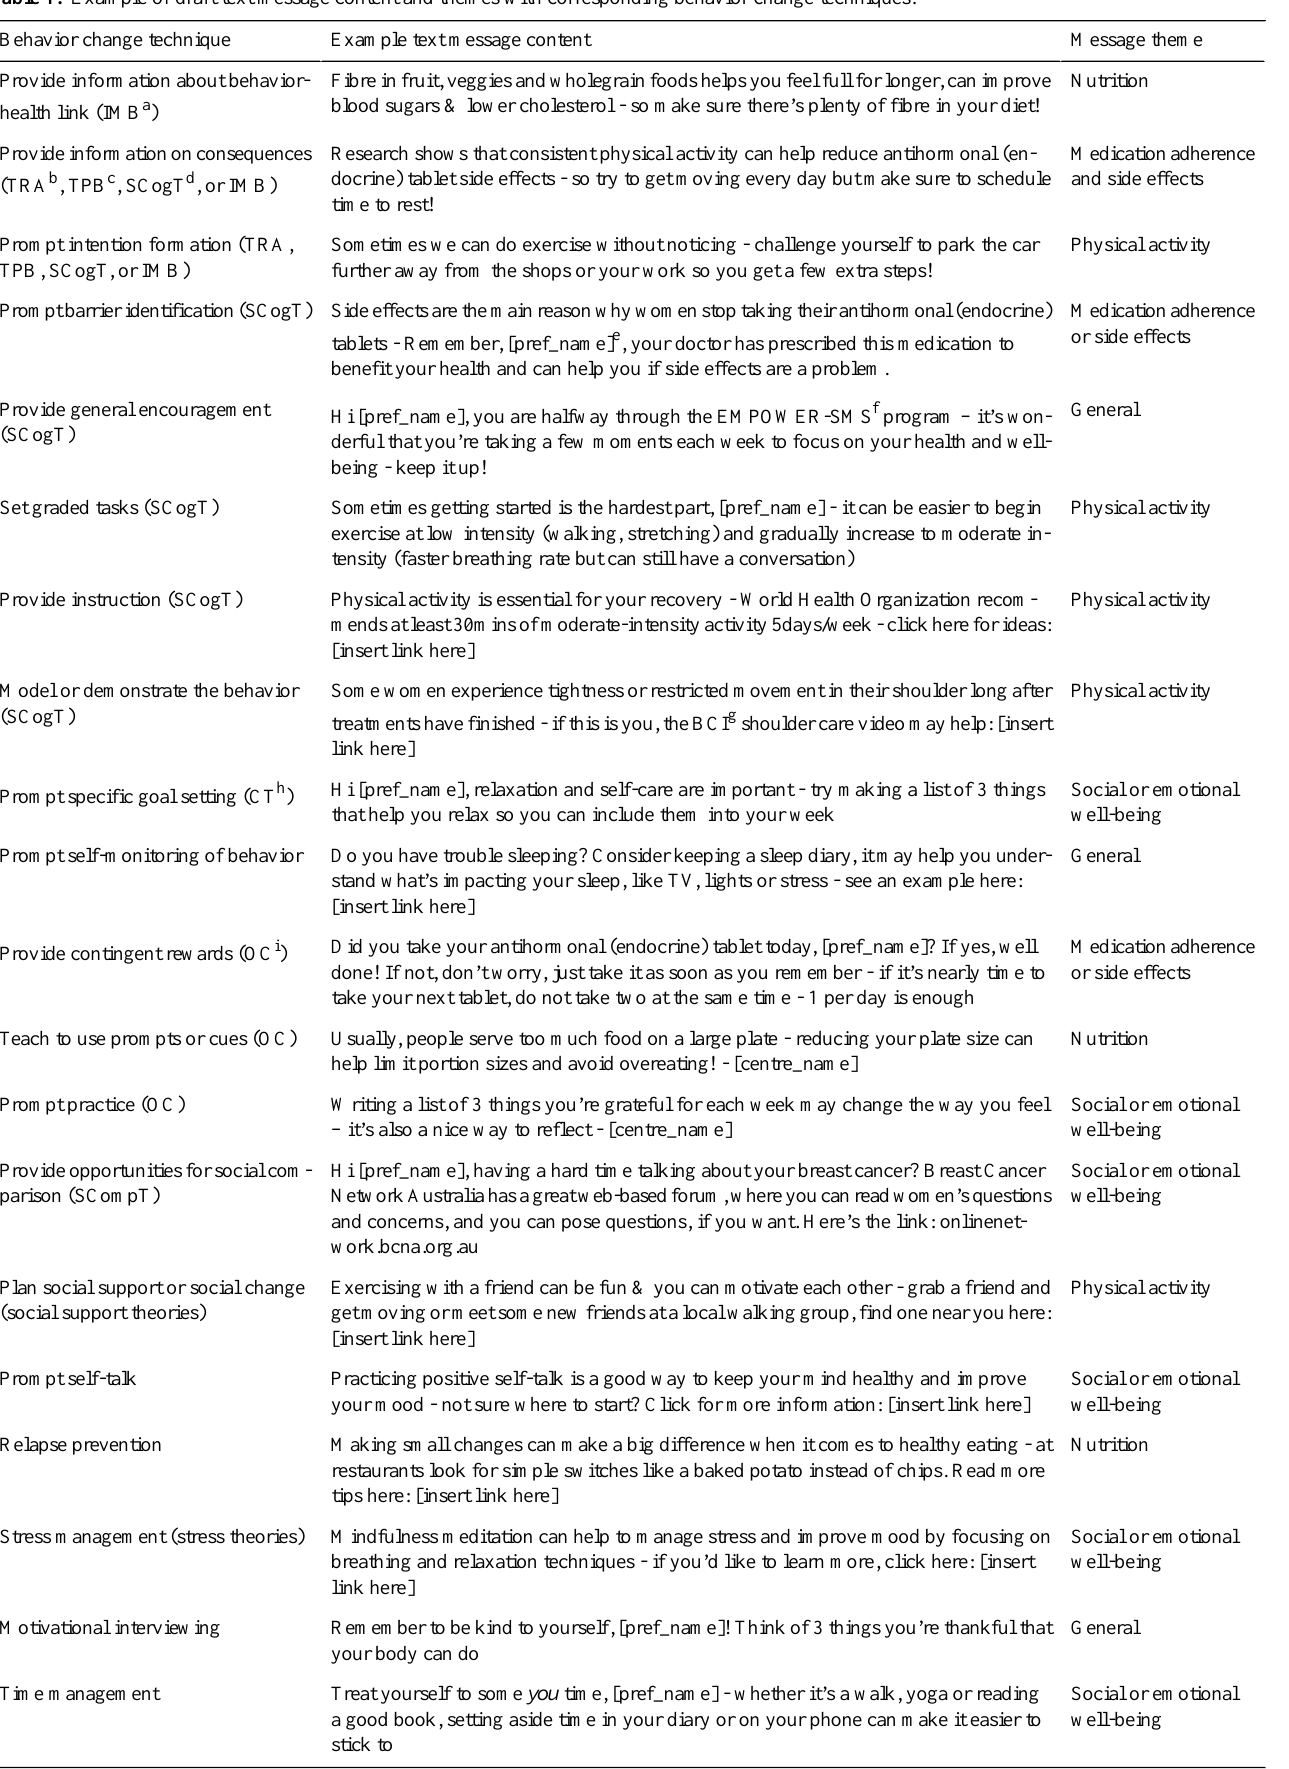
Table 1. Example of draft text message content and themes with corresponding behavior change